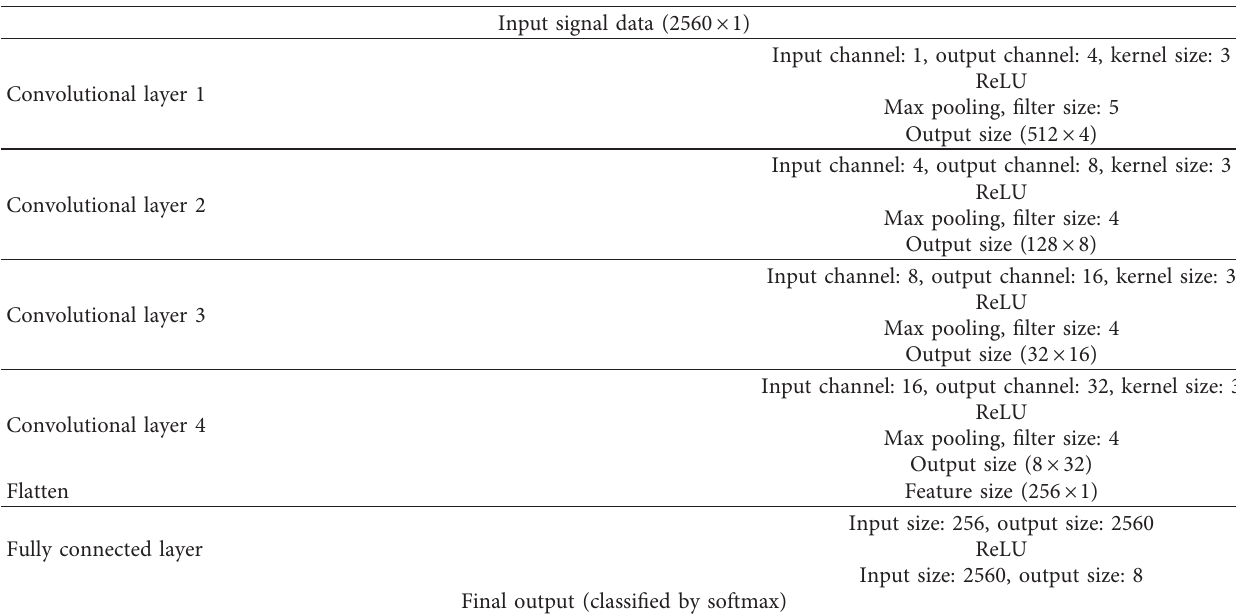
Table 2: CNN structure.